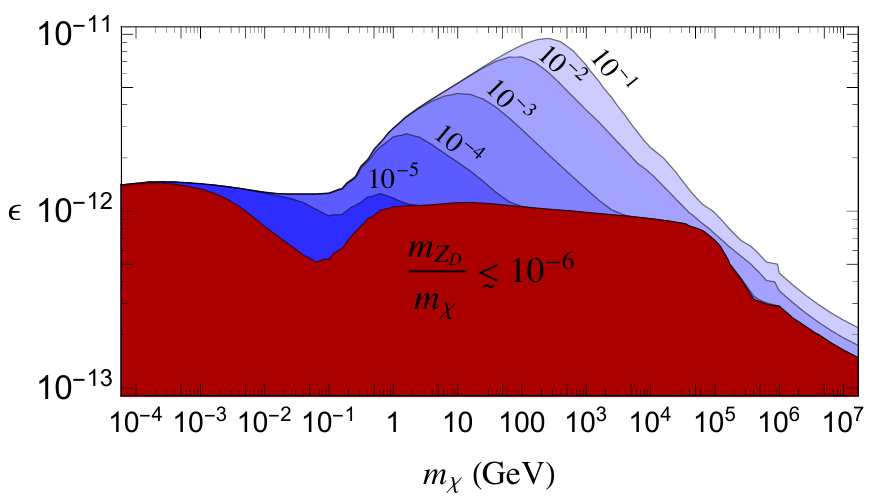
Figure 12. The regions where our B (cid:0) L model does not internally thermalizes for di(cid:11)erent contours of m Z =m (cid:31) . As m Z gets closer to m (cid:31) , the inelastic scattering processes become less e(cid:14)cient. For D D m Z =m (cid:31) . 10 (cid:0) 6 , the inelastic processes are maximally e(cid:14)cient and do not bene(cid:12)t from smaller D mass ratios. At low dark matter masses, the elastic processes dominate the thermalization, sculpting the region in the upper left part of the